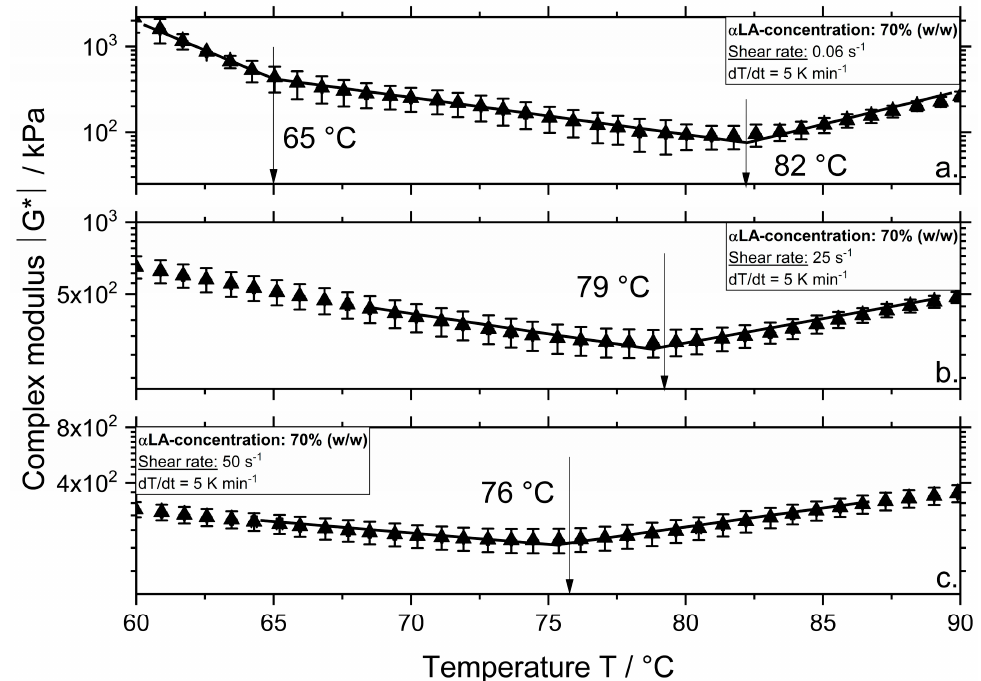
Figure 3. Complex modulus | G ∗ | as a function of temperature for systems with a α LA concentration of 70% ( w / w ) and a shear rate of 0.06 ( a ), 25 ( b ), and 50 s − 1 ( c ). Measurements were performed at a constant heating rate of 5 K min − 1